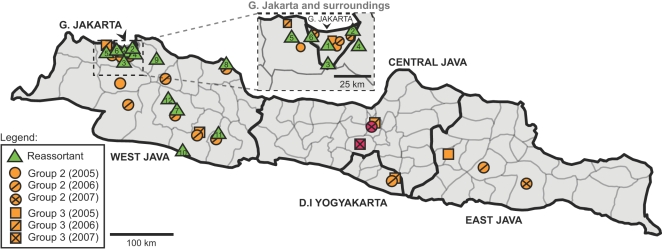
Map of mainland Java in Indonesia.Locations for the putative reassortant viruses focused in this study are indicated with green triangles. Numbers inside the triangles refer to the locations of the reassortant viruses described in Table 1. Locations of group 2 and 3 viruses are indicated with orange circles and squares, respectively. Red circles and squares denote the locations of putative avian reassortant viruses in 2007. Only those parental strains genetically close to the reassortant viruses are shown in the map. A zoom-in of Greater Jakarta (G. Jakarta) and surroundings is illustrated separately in a dashed-line bounded box in the centre of the figure.